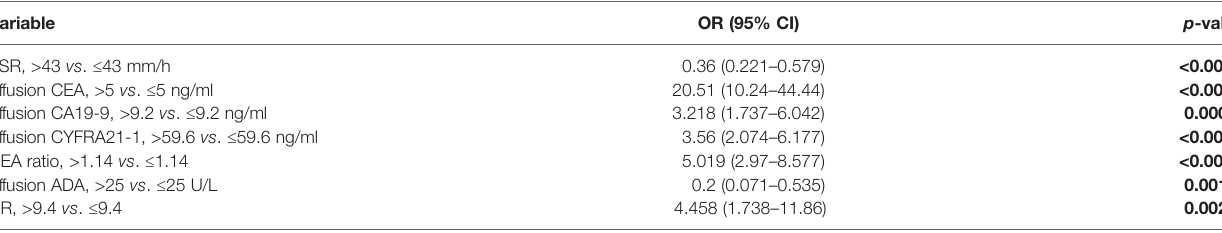
TABLE 2 | Multivariate logistic regression analysis of the clinical parameters in the training set. Variable